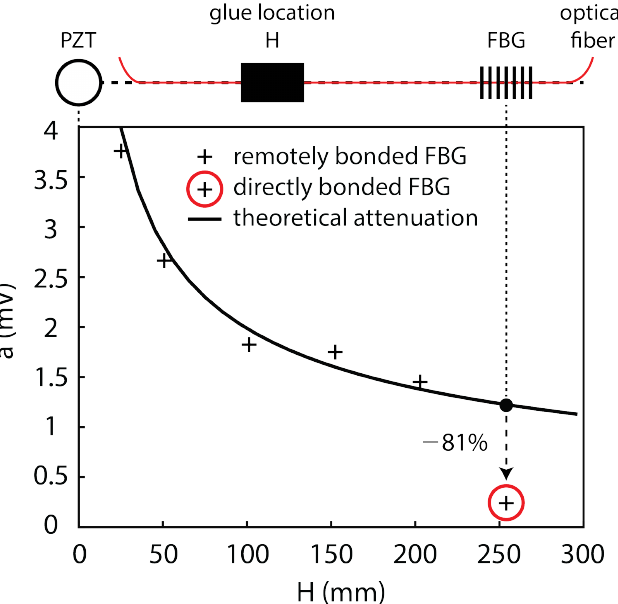
Figure 16. Theoretical amplitude of FBG output as a function of distance from PZT source and experimentally measured signal amplitudes. The circled data point indicates the directly bonded FBG